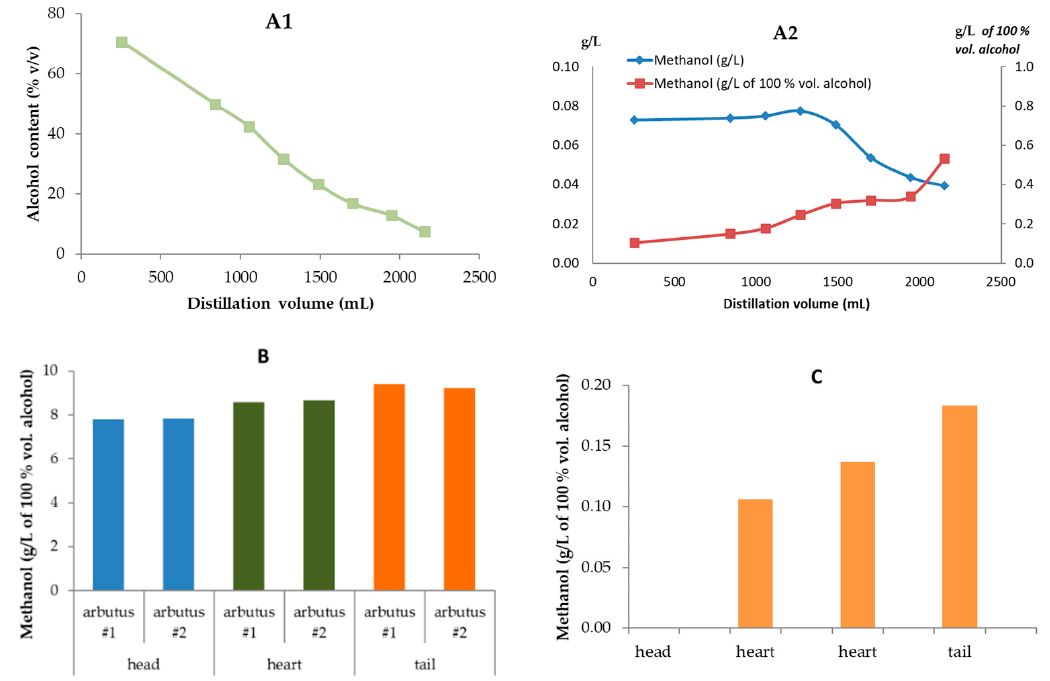
Figure 1. Variation of ethanol ( A1 ) and methanol ( A2 , B , C ) contents over distillation to obtain different spirits ( A -wine spirit; B -arbutus spirit and C -honey spirit).